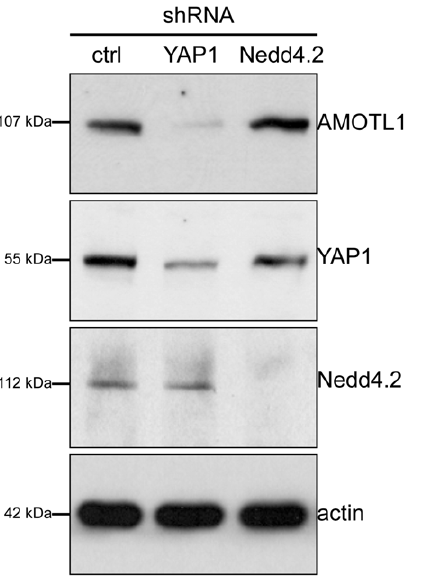
Figure 5. Depletion of endogenous YAP1 or Nedd4.2 affects endogenous AMOTL1 levels. HEK293T cells were transiently transfected with either YAP1 or Nedd4.2 shRNA. Even a small reduction of YAP1 results in almost complete absence of AMOTL1. However depletion of Nedd4.2 maintains AMOTL1 levels. Actin was used as a loading control.